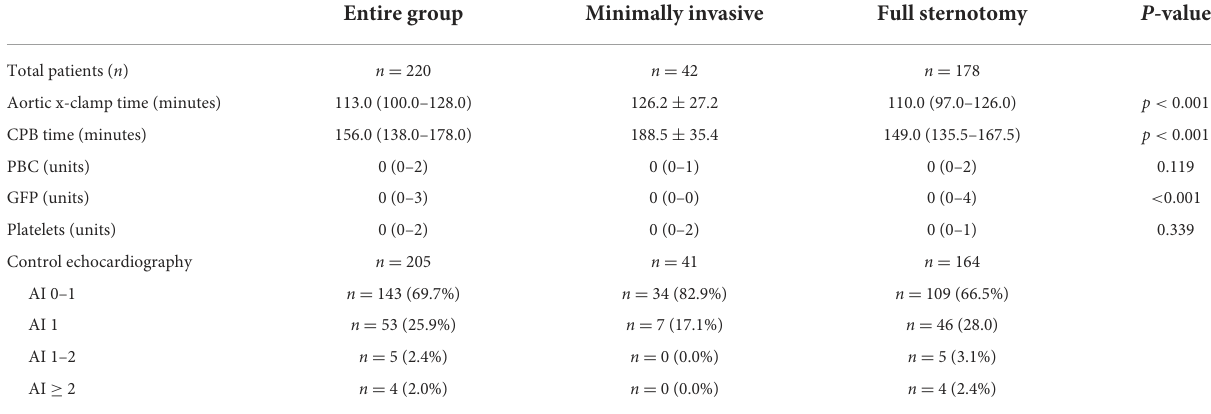
TABLE 2 Intraoperative data.